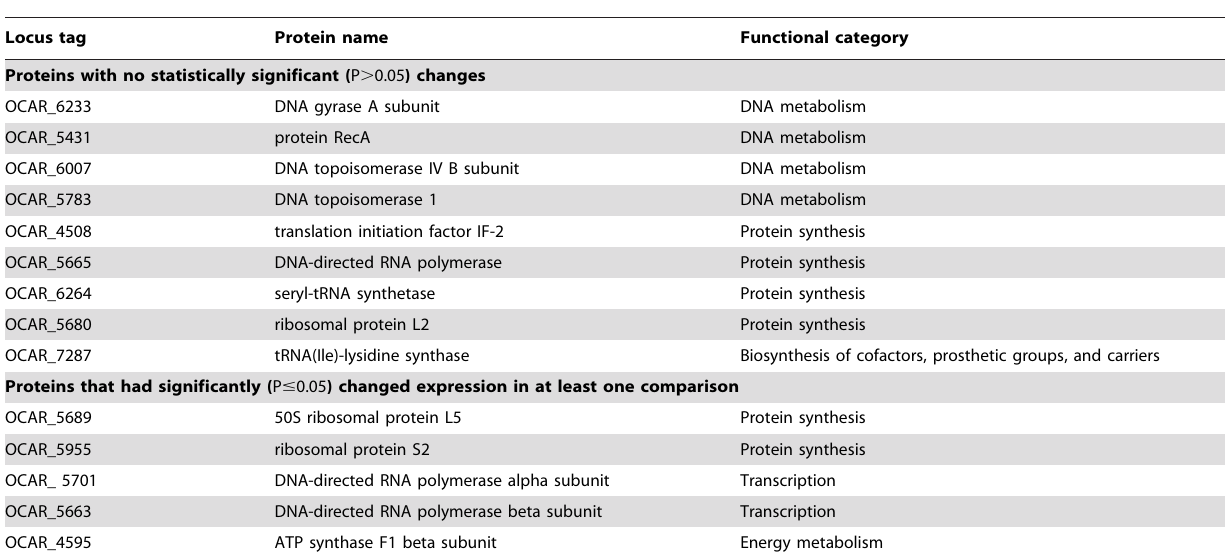
Table 2. O. carboxidovorans growth phase proteins identified in this study.